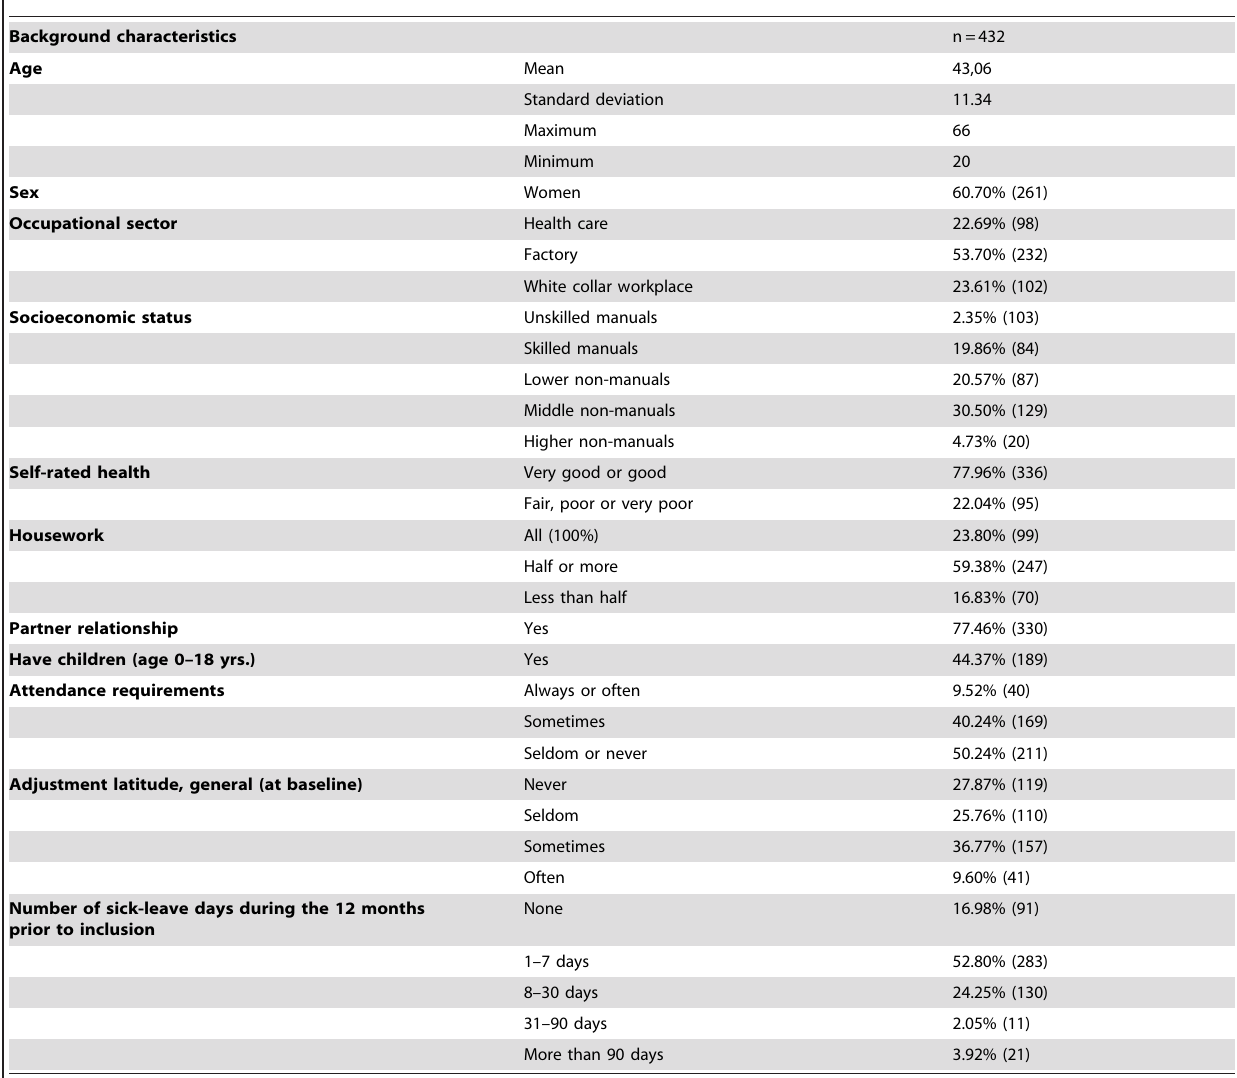
Table 1. Background characteristics of interviewed sickness absentees.